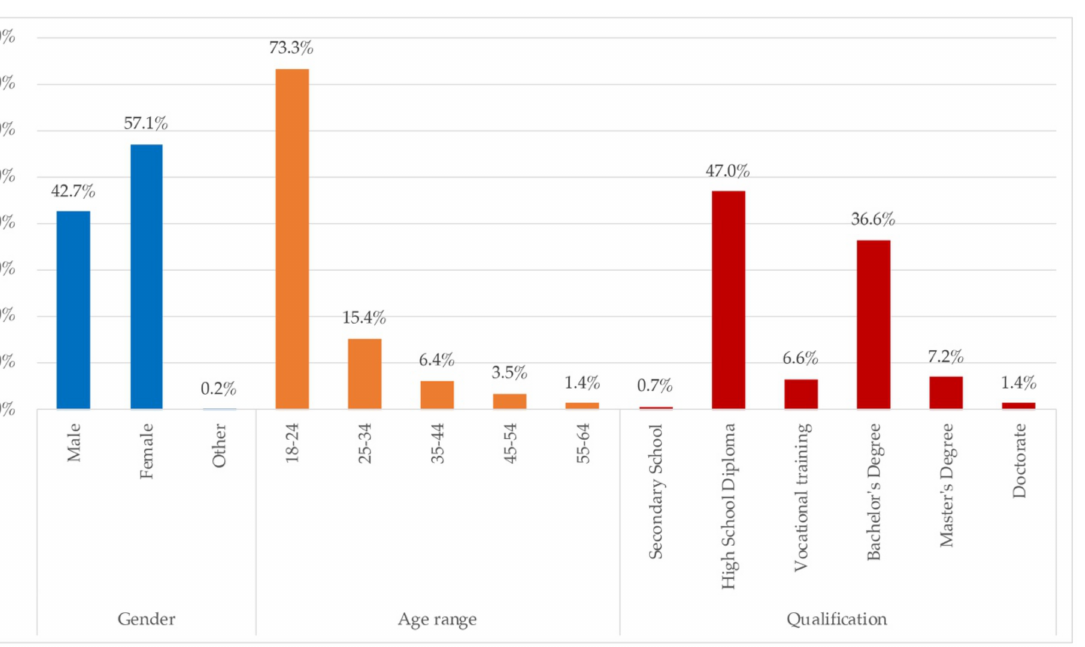
Figure 15. Population distribution of participants who contributed photographs to the mixed